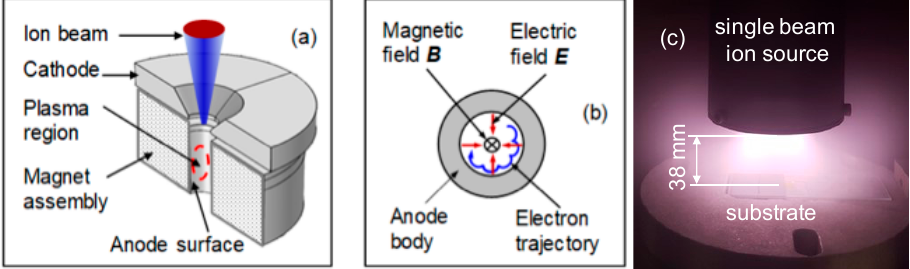
Figure 1. ( a ) Profile side view and ( b ) top view of the single beam plasma source. ( c ) Plasma discharge image of the single beam ion source.